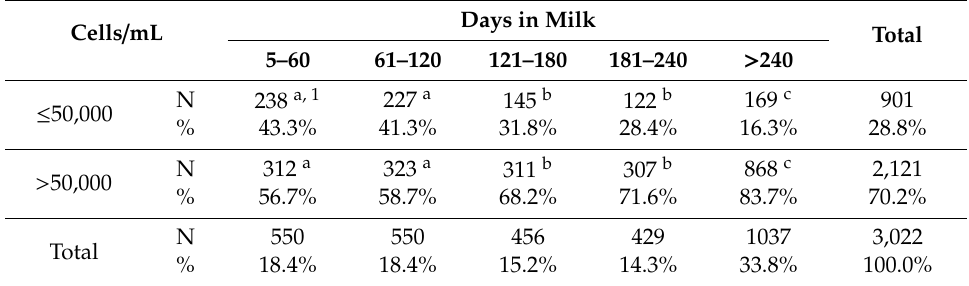
Table 4. Distribution of samples by days in milk and SCC level (threshold ≤ 50,000 /> 50,000 cells / mL). Cells /